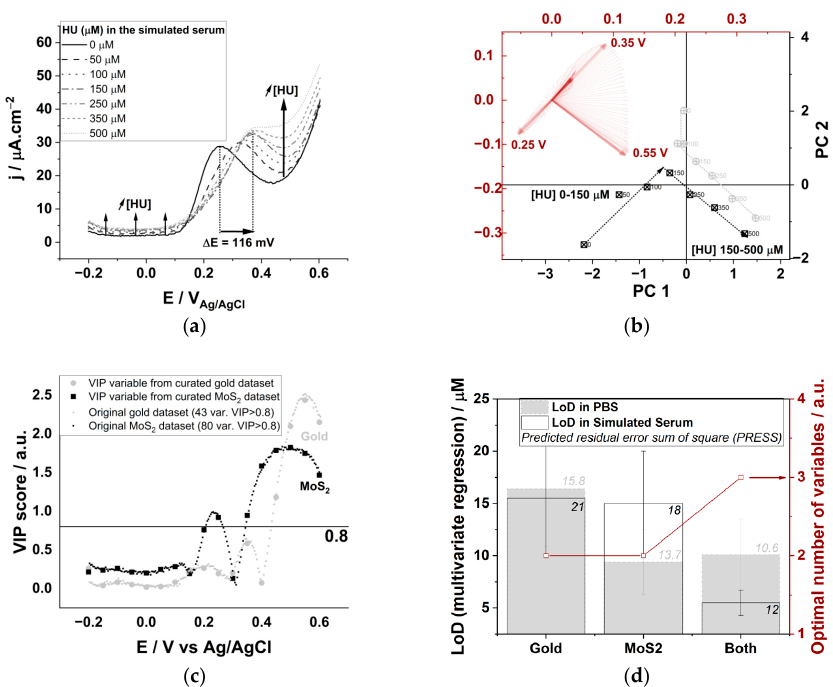
Figure 4. ( a ) Differential pulse voltammograms corresponding to the gradual increase of hydroxyurea (HU: 0, 50, 100, 150, 250, 350, and 500 mM) in a buffered simulated serum composed of 28 redox active molecules in their physiological con- centration range acquired with the MoS 2 modified electrode. ( b ) Principal component analysis of the DPV datasets for HU calibration within its clinical concentration range (0–500 mM) using both the bare (grey) and the MoS 2 modified (black) electrodes dataset. The loading plot (red) displays the covariance of variables with HU concentration variation. ( c ) Very important variable (VIP) score plot resulting from the partial least square analysis of each DPV dataset for increasing HU concentrations. ( d ) The limit of detection calculated with the multivariate regression model for the isolated and combined electrodes datasets. To increase the optimal number of variables (red) allows for the decrease in the predicted residual sum of square (PRESS, associated to the column plots).